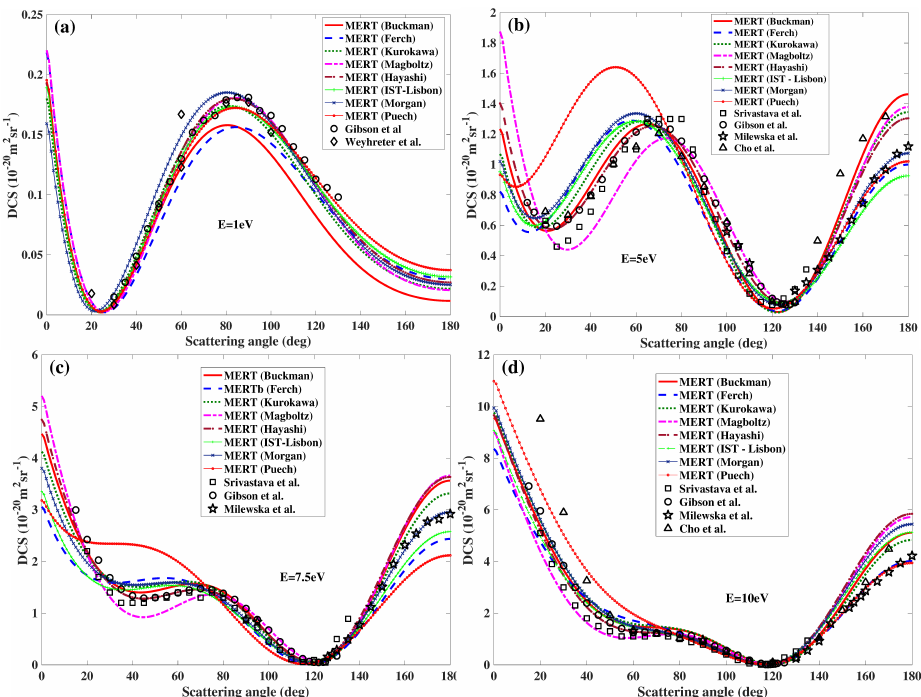
Figure 5. Angular dependencies of MERT − derived differential cross − sections at ( a ) 1, ( b ) 5, ( c ) 7.5, and ( d ) 10 eV for e − − Ar scattering. The present results are compared with experimental data of Gib- son et al. [54], Weyhreter et al. [55], Cho and Park [56], Srivastava et al. [57], and Milewska et al. [58].